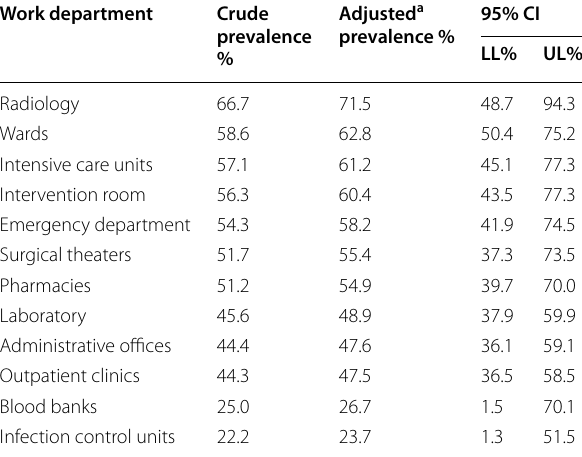
Table 2 Prevalence of anti‑S positive results among 416